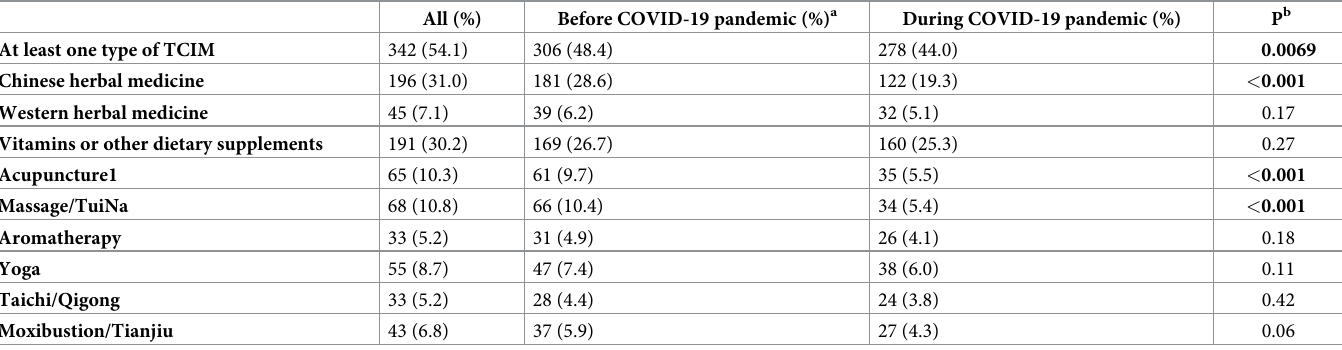
Table 2. Pattern of TCIM use before and during COVID-19 (n = 632).